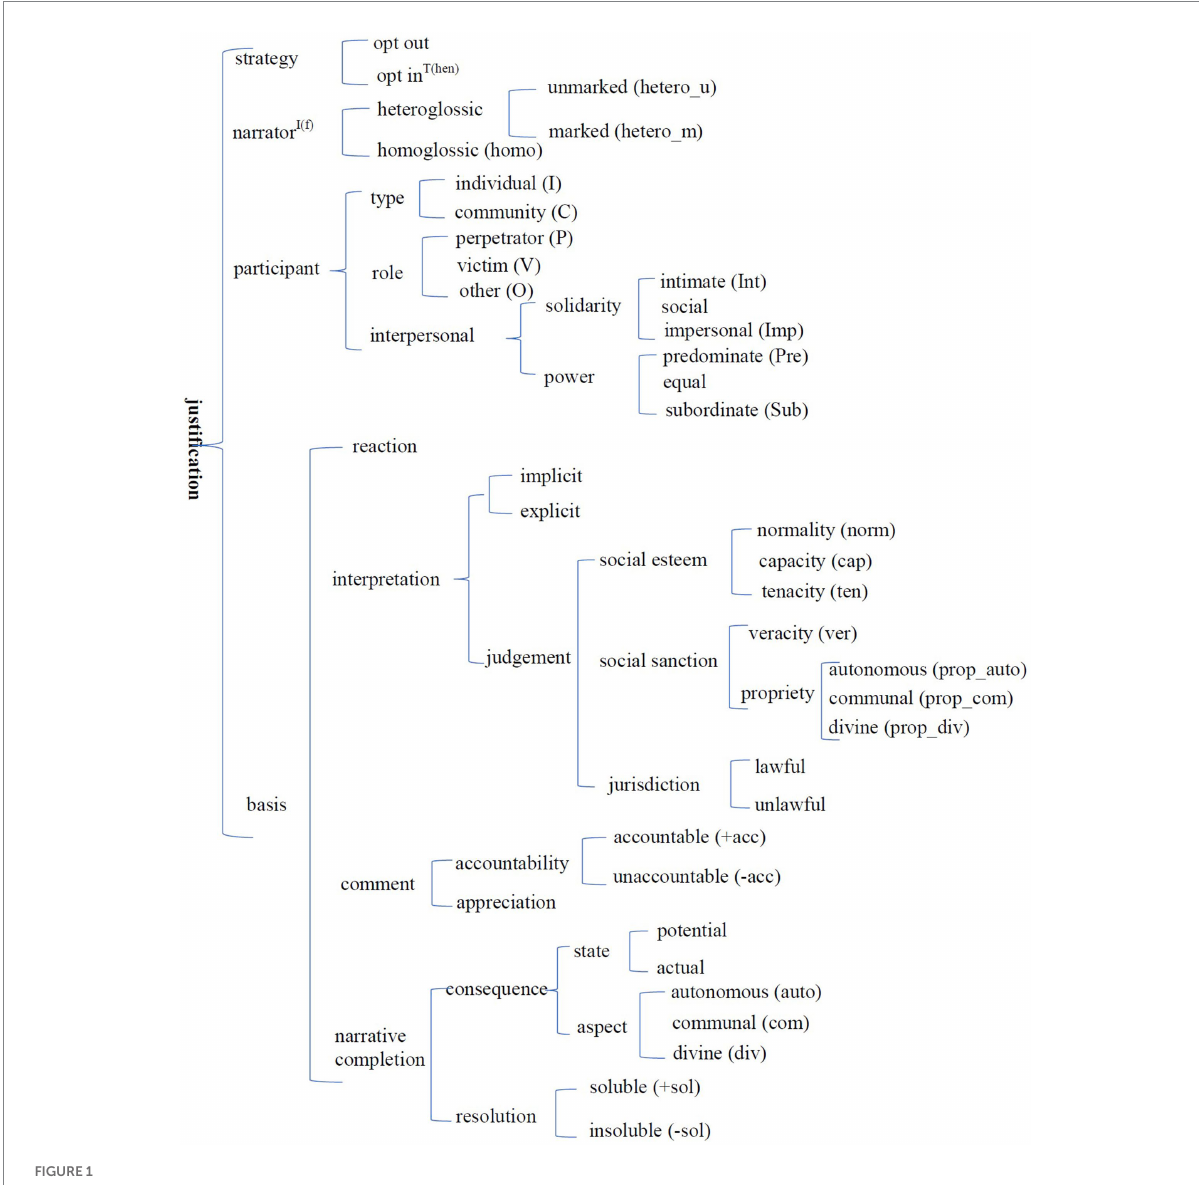
FIGURE 1 System network of